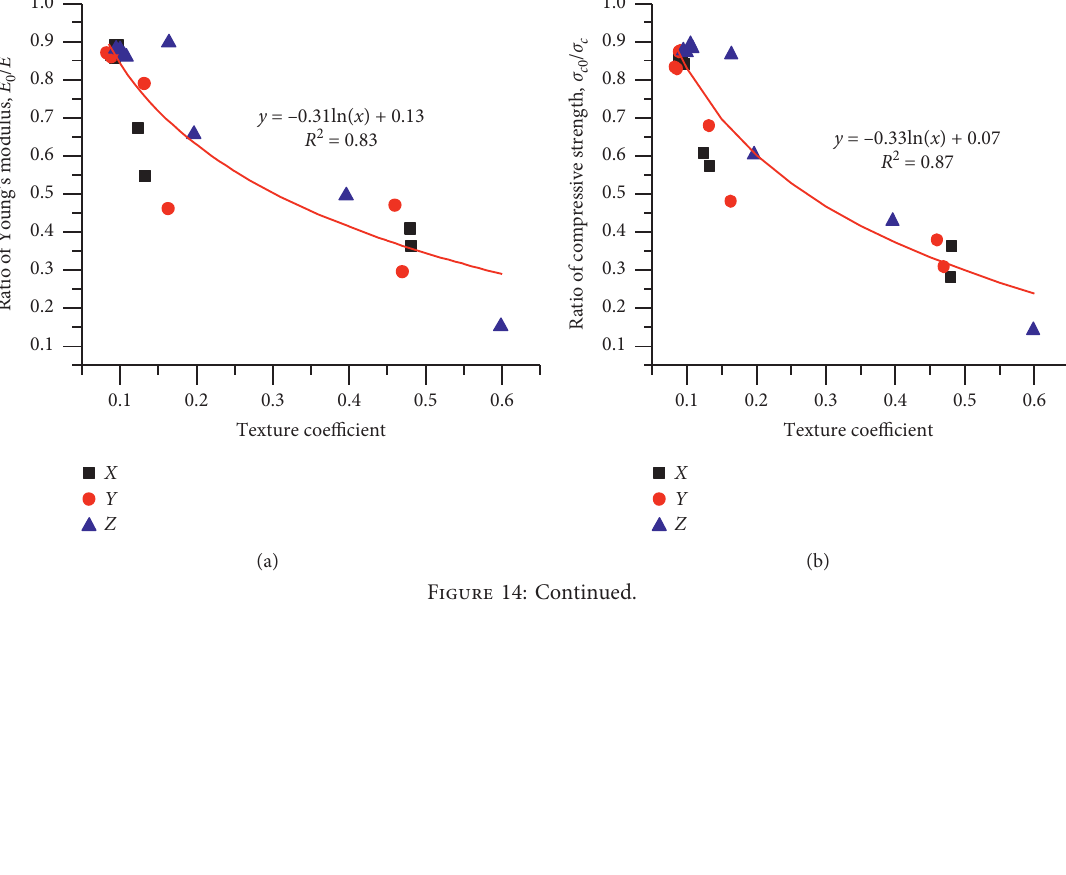
y = –0.31ln( x ) + 0.13 R 2 =